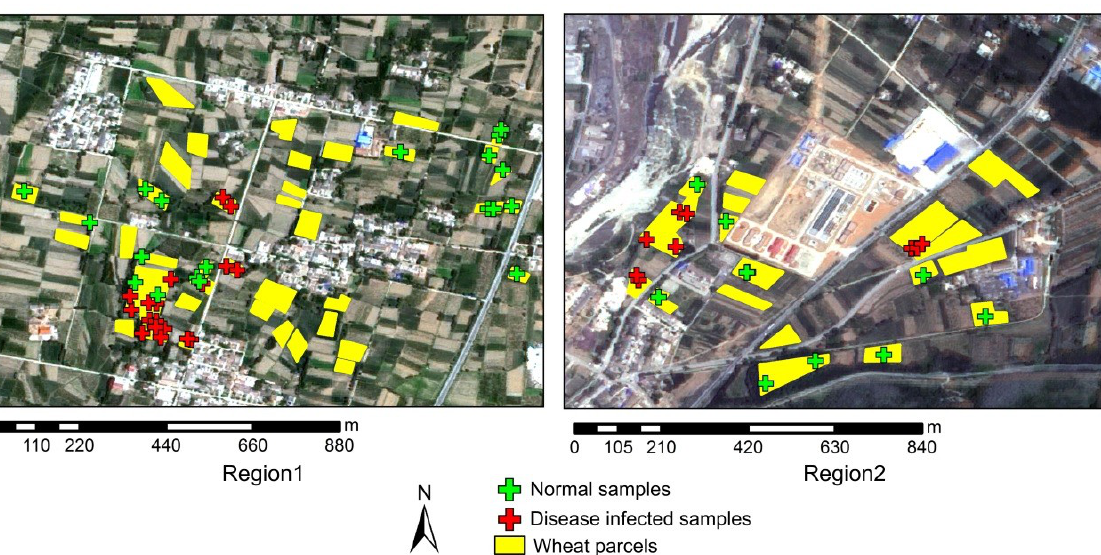
Figure 2. Maps showing survey plots in two study regions in